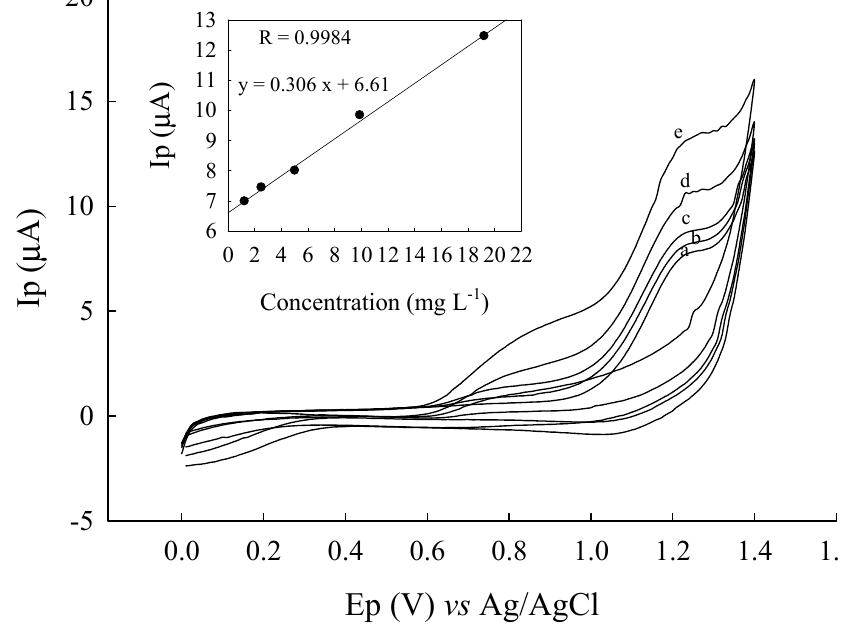
Figure 5. Cyclic voltammograms of cysteine after different concentrations at an Au/CFE electrode and after related current-concentration curve: ( a ) 1.25 mg·L − 1 ; ( b ) 2.5 mg·L − 1 ; ( c ) 5.0 mg·L − 1 ; ( d ) 10 mg·L − 1 ; ( e ) 20 mg·L − 1 in Britton-Robinson buffer (pH 5.33) solution, scan rate at 50 mV/s.